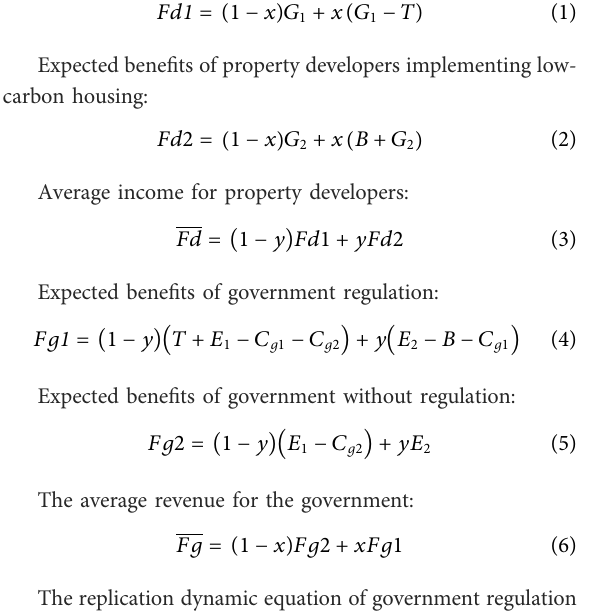
Expected bene fi ts of property developers implementing low-